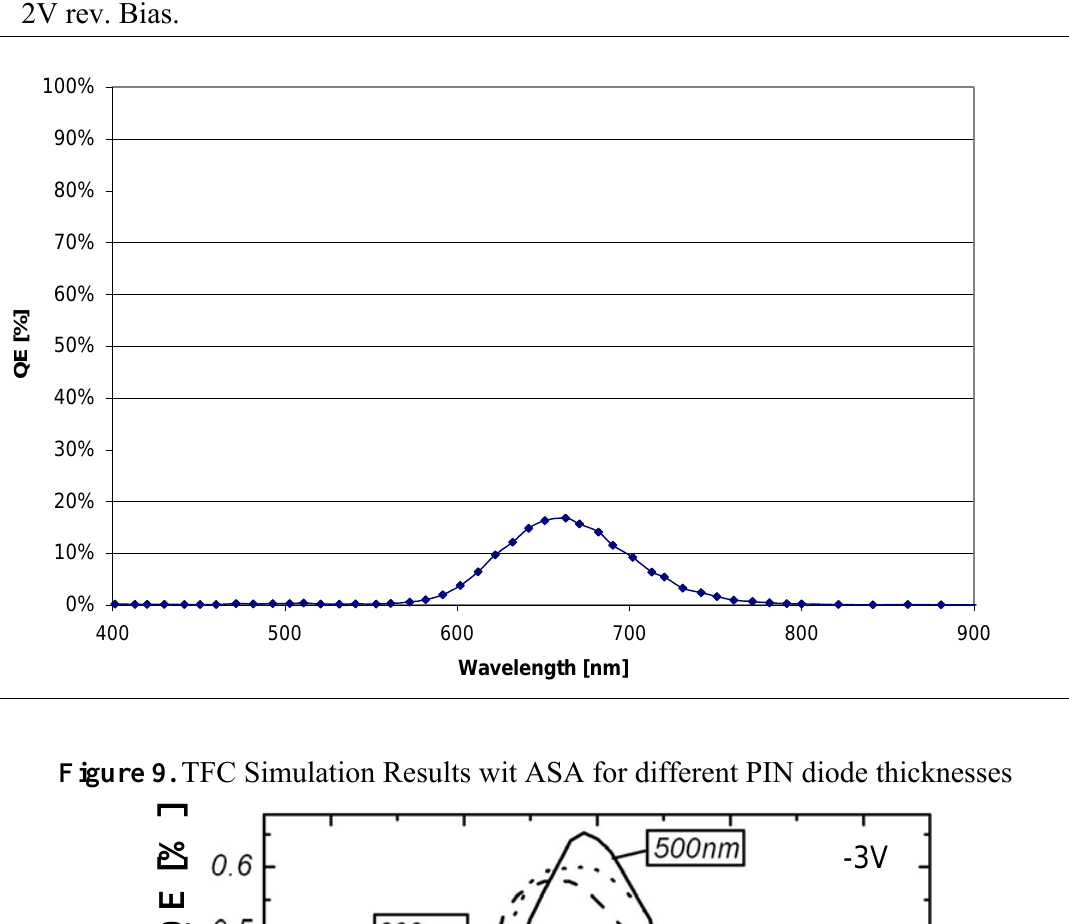
Figure 8. Quantum efficiency of a 2µm thick TFC PIN-diode. Diode area = 0.9 mm 2 @ 2V rev. Bias.